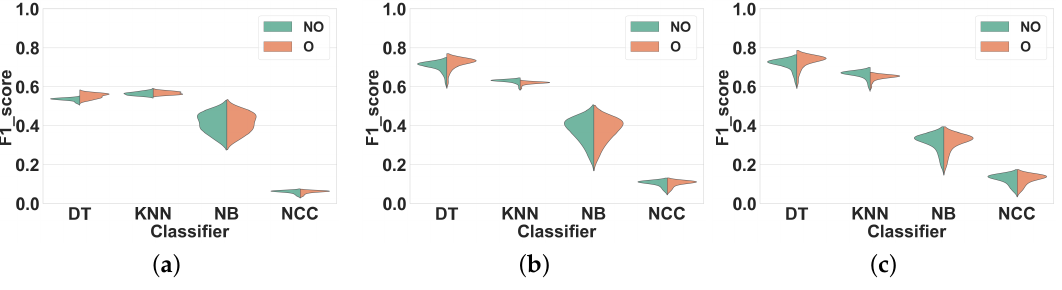
Figure 8. Experiment 2–Subject-independent CV–Dataset 2. ( a ) FS1; ( b ) FS2; ( c ) FS3.